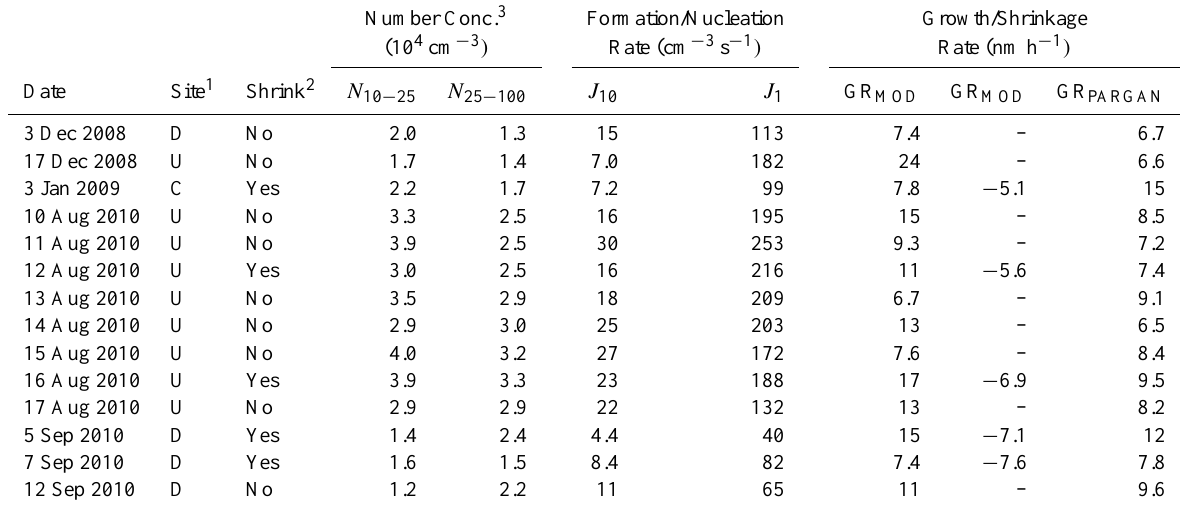
Table 3. The size-segregated particle number concentration, formation/nucleation and growth/shrinkage rates during the NPF events. Number Conc.